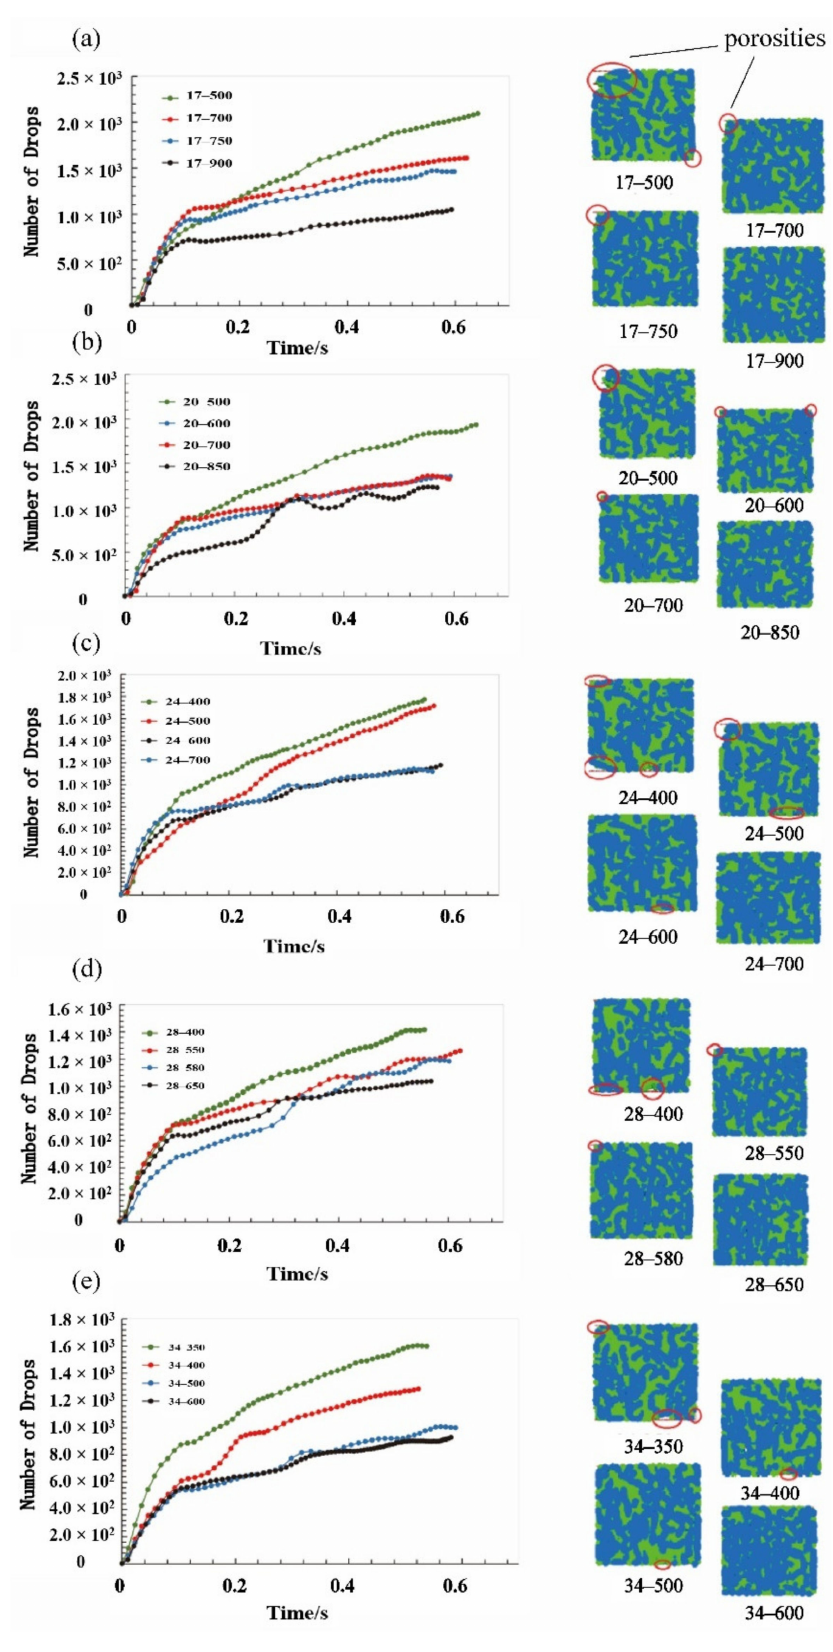
Figure 9. The development of drops number along the simulation and the cross section of the sealing grease models at different fiber’s aspect ratio, including ( a ) 17, ( b ) 20, ( c ) 24, ( d ) 28 and ( e )